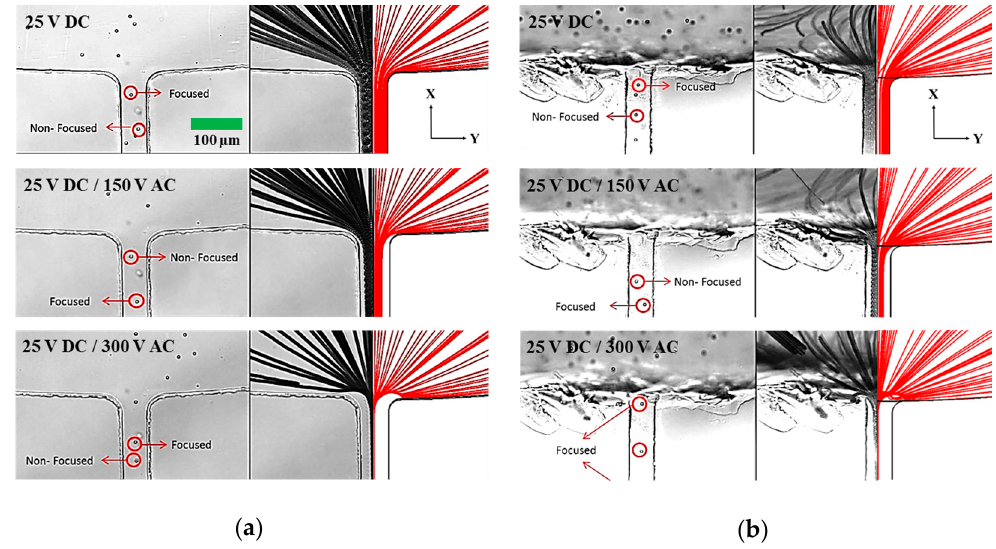
Figure 3. Comparison of the experimentally obtained and numerically predicted path-lines of 5 µm latex beads at the reservoir-microchannel junction of ( a ) 2DrDEP device and ( b ) 3DrDEP device plotted in the top view (X-Y). Three voltage settings are used for comparison, namely 25 V DC, 25 V DC/150 V AC, and 25 V DC/300 V AC. Note that in both devices, the rDEP focusing effect increases with an increase in AC voltage, and the beads get deflected towards the center-line of the channel. Also observe that for all the voltages, some of the focused beads in the 2DrDEP device ( a ) appear blurred in the field of view of the microscope, indicating an absence of a three-dimensional focusing. In contrast, all the beads in the 3DrDEP device ( b ) appear sharply focused at higher voltages, indicating a three-dimensional focusing effect towards the channel center-line and the channel bottom.